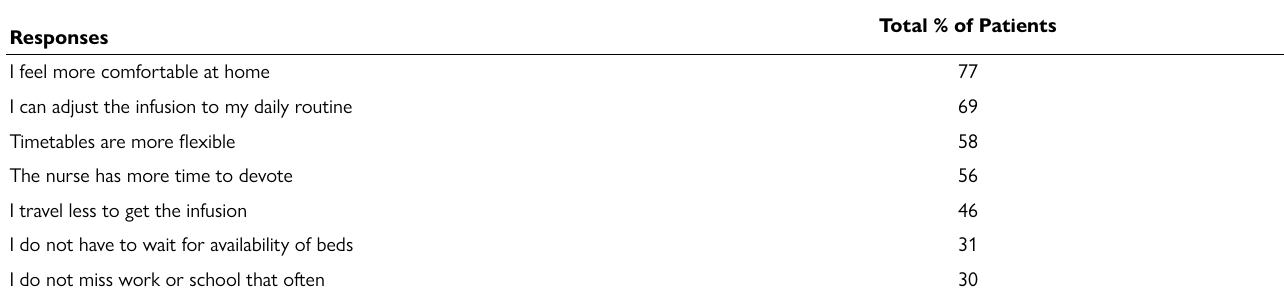
Table 4. Advantages of home infusion